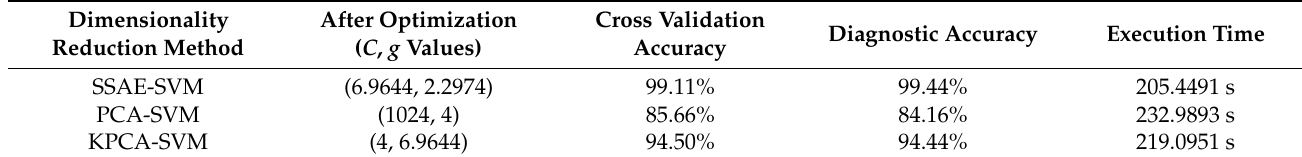
Table 6. The classification results of different dimension reduction methods.